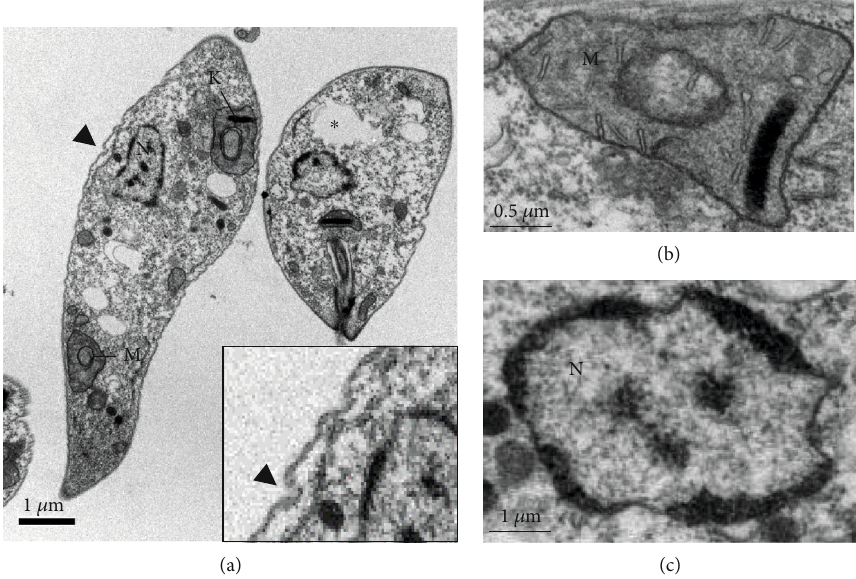
Figure 3: Ultrastructure of promastigote forms of L. ( L. ) infantum treated with IC lost the fusiform shape, displayed cell membrane protrusions (arrowhead) and areas of cytoplasm degradation ( ∗ ); (b) detail of the mitochondria and kinetoplast from parasites treated with Lu ( × 50K); (c) nucleus showing condensed and fragmented chromatin after Lu treatment ( × 50K).